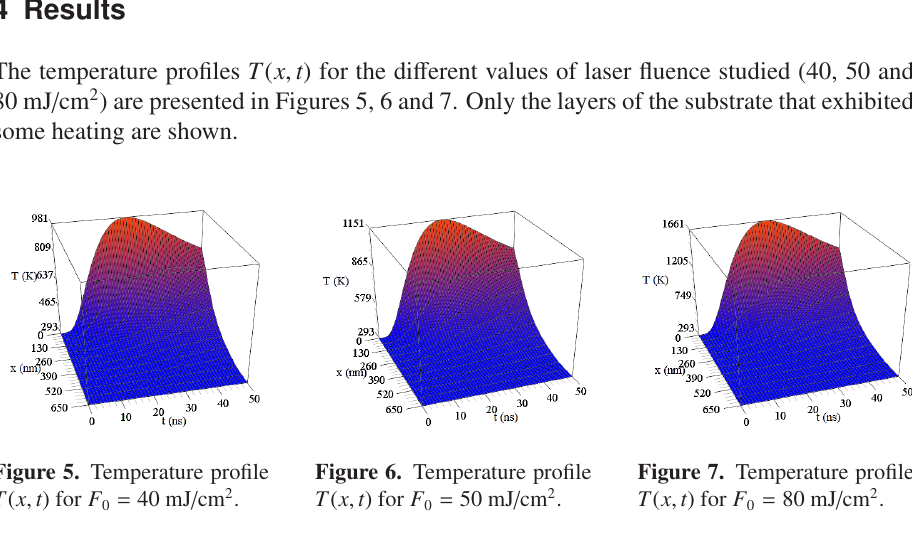
Figure 9. Temperature profile T ( t ) for F 0 = 50 mJ / cm 2 .